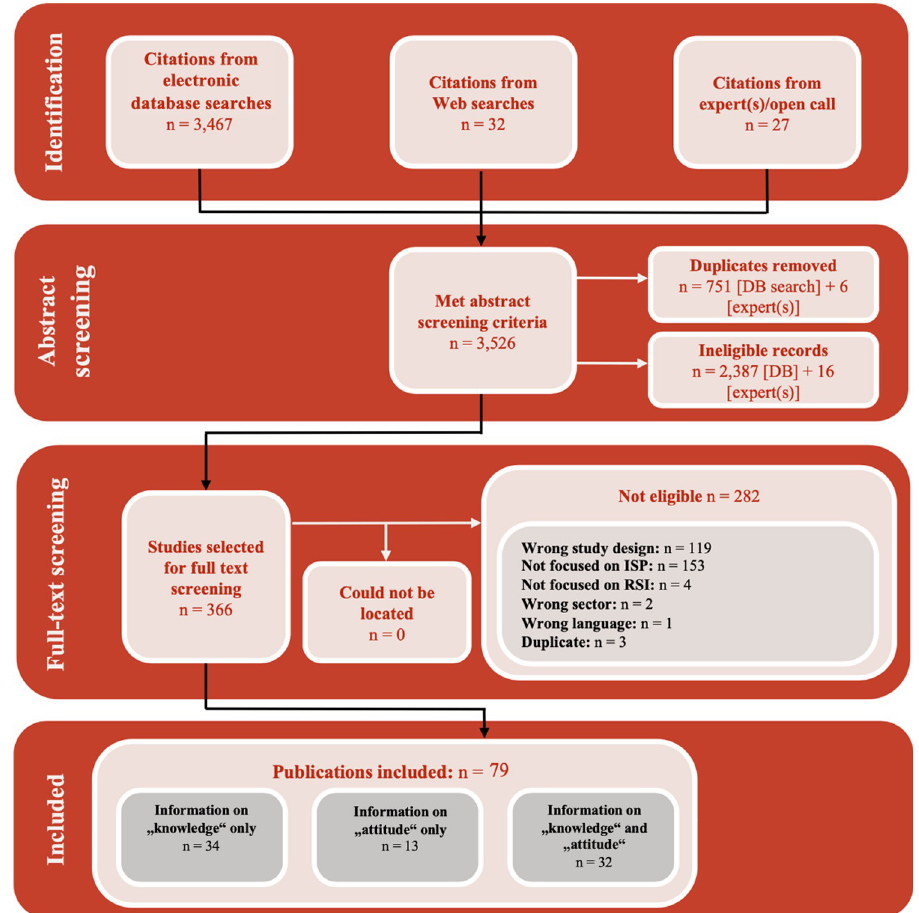
Fig 1. Flow of studies through the review